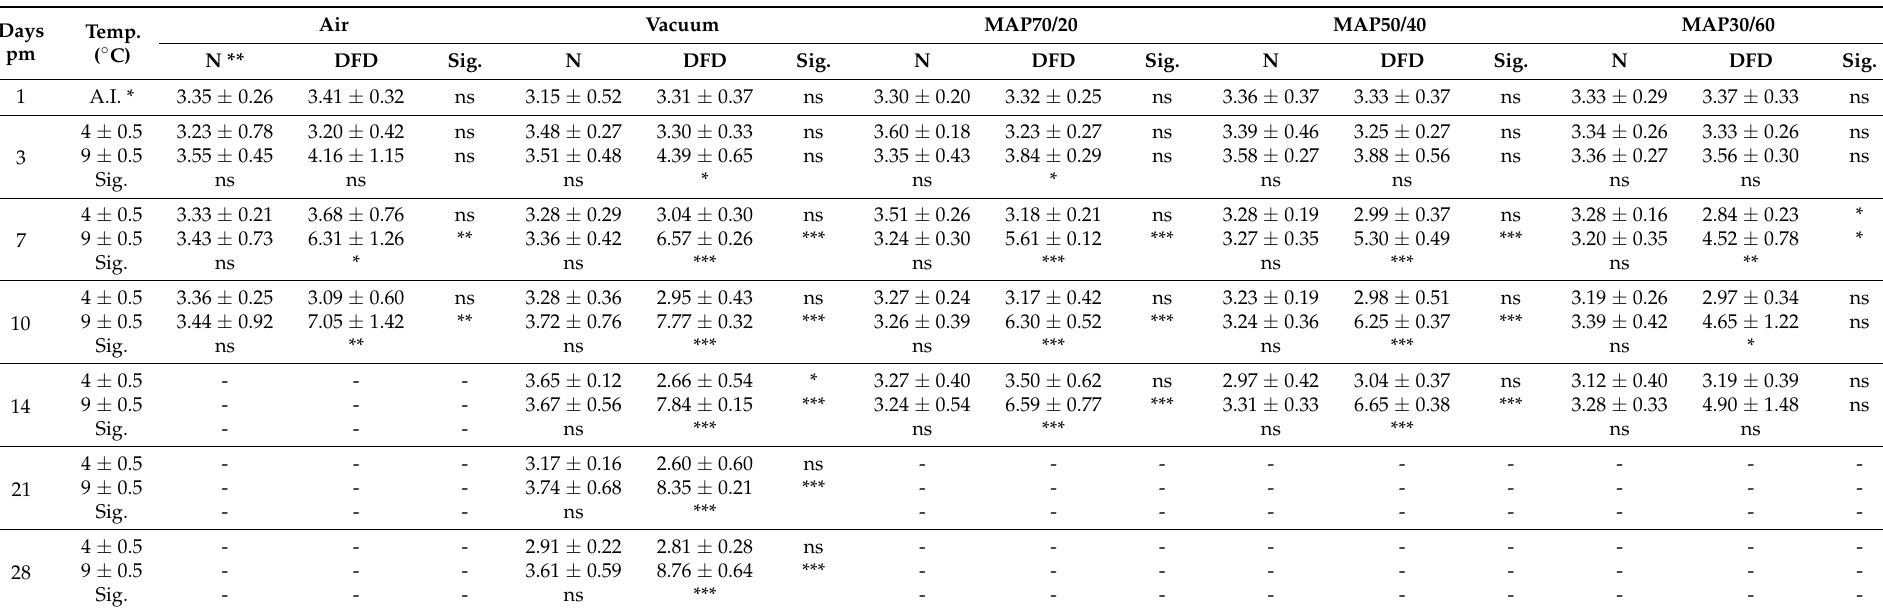
Table 1. Counts of E. coli O157:H7 (log CFU/g) in inoculated beef samples according to pH groups (Normal and DFD) in five different packagings and stored at